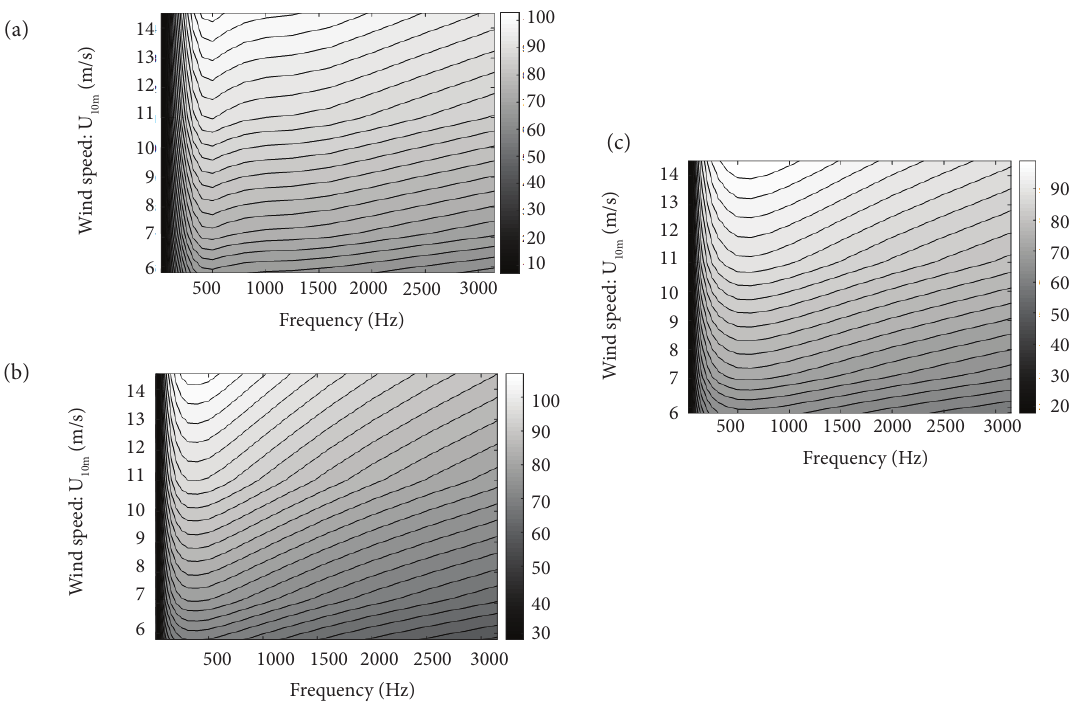
Figure 4. Illustration of TBL-TE contours, Sound Power Level (dBA) prediction from (a) BPM; (b) Lowson; and (c) Grosveld baseline models at fixed rotor speed of 15 RPM for wind speeds 8-15 m/s, receiver height of 2 m, at distance of ~120 m, i.e. total turbine height (HH+D/2).